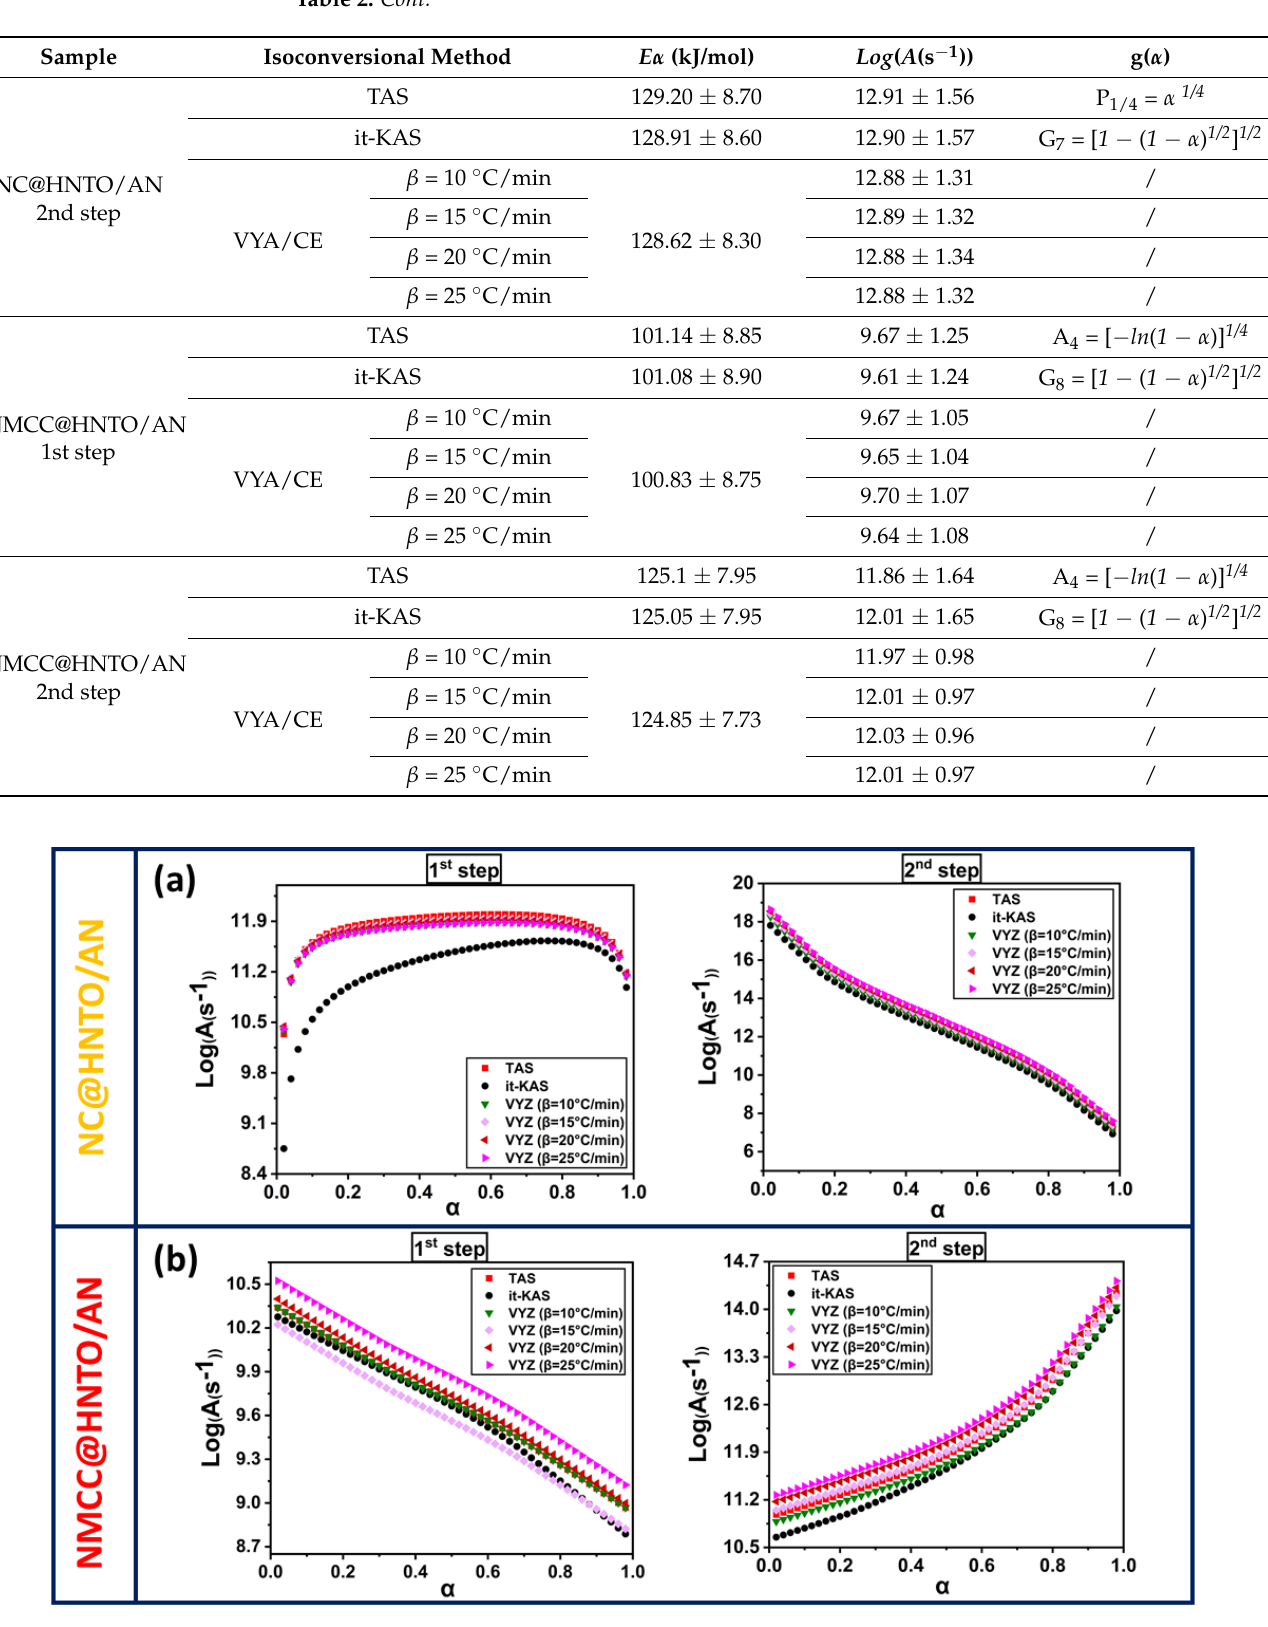
Figure 6. Evolution of the decimal logarithm of the pre-exponential factor as a function of conversion for the di ff erent stages of decomposition of ( a ) NC@HNTO/AN; ( b ) NMCC@HNTO/AN.